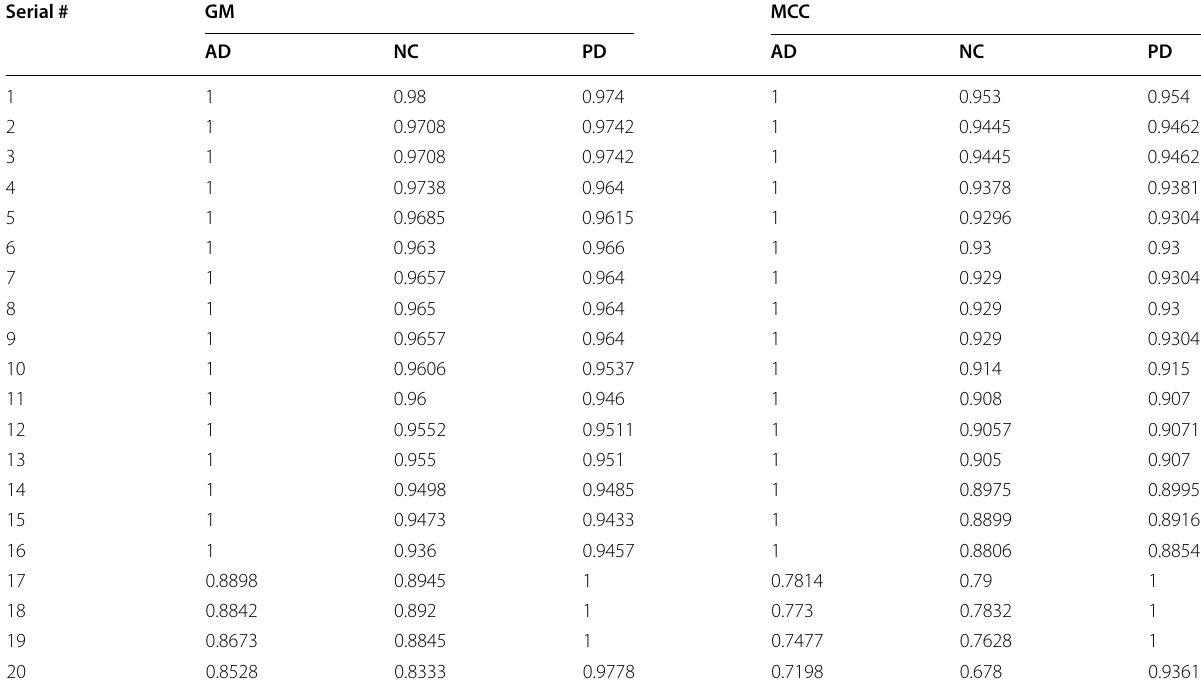
Table 6 GM and MCC performance metrics for the methods